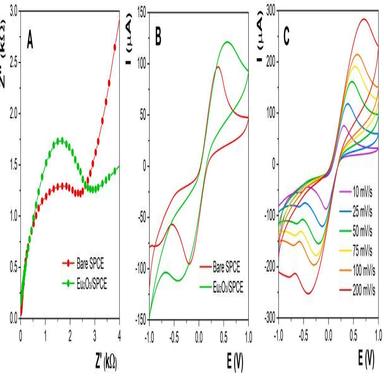
A) EIS spectra of the bare SPCE and Eu2O3/SPCE; B) CV voltammograms at 50 mV/s for bare SPCE and Eu2O3/SPCE; C) CV voltammograms at various scan rates at Eu2O3/SPCE. Testing solution 5 mM of Fe2+/3+ in 0.1 M KCl.